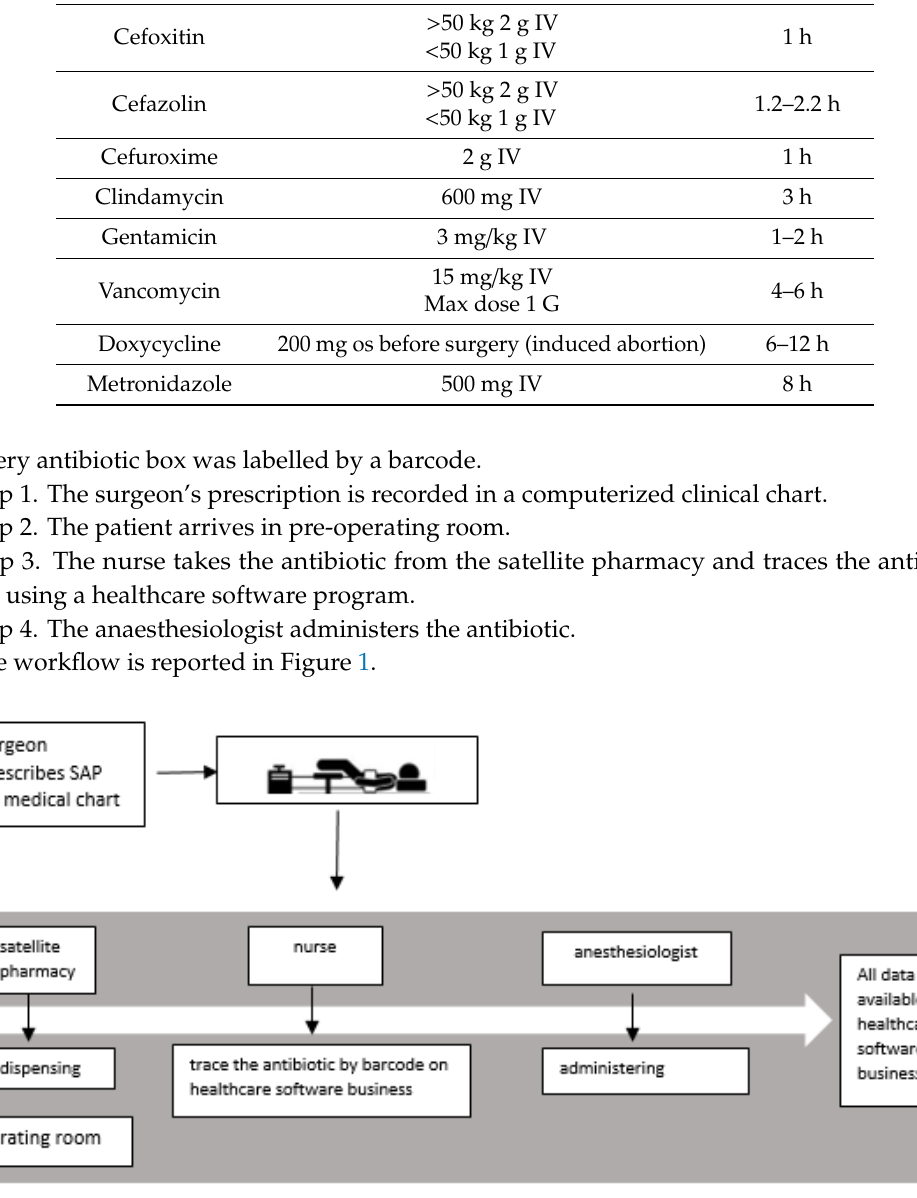
Table 1. Dose and half-life of antibiotics planned for Surgical Antibiotic Prophylaxis (SAP).